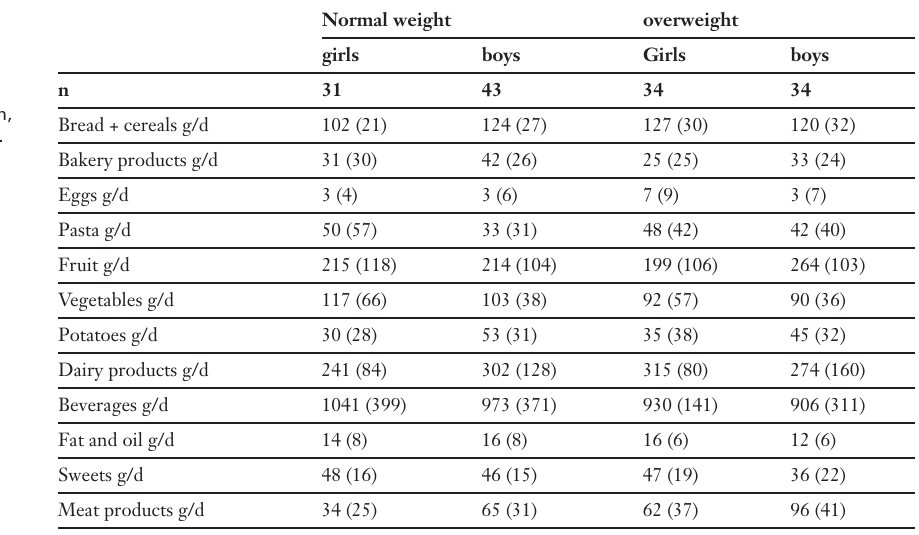
Intakes of selected food groups by normal weight and overweight children, grouped by